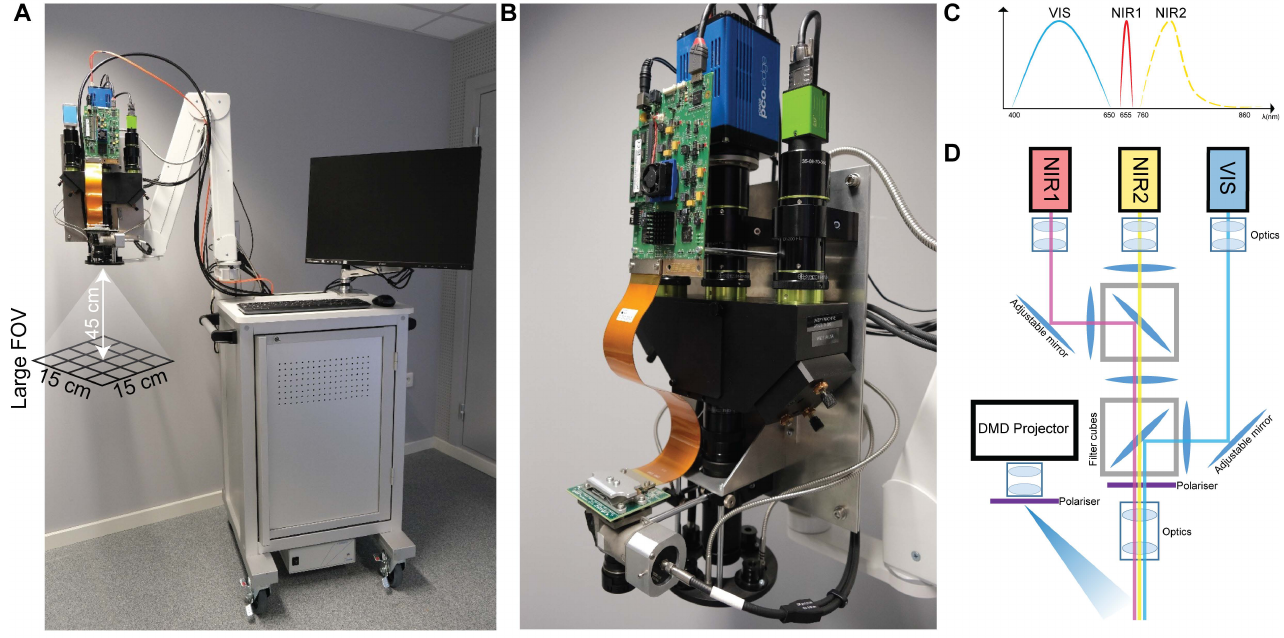
Figure 2. SSOP descriptive figure. ( A ) Preclinical cart for fluorescence, SFDI, and SSOP imaging in the operating room. The imaging head is mounted onto an articulated arm for an easy positioning over the surgical table at the desired working distance. The main body of the cart contains the laser sources, the white light lamp, and the PC workstation. ( B ) Imaging head based on a trident architecture to enclose three separate channels for RGB, NIR1, and NIR2 imaging. A DMD-based projection system is also mounted onto the head for the generation of structured illumination over the FOV. The light source is delivered to the projector via a fiber-based coupling system. An illumination ring is used to homogeneously deliver white light illumination of the surgical field and fluorescence excitation wavelength. ( C ) Schematics of the imaging bands for the trident, namely: the RGB camera (JAI GO-5000C-USB, JAI Ltd., Kanagawa, Japan) covers the VIS bandwidth (400–650 nm); the NIR1 camera (pco.pixelfly USB, Excelitas PCO GmbH, Kelheim, Germany) covers the first near-infrared bandwidth (centered around 665 nm); and the NIR2 camera (pco.edge 5.5, PCO AG, Excelitas PCO GmbH, Kelheim, Germany) covers the second near-infrared bandwidth (700–900 nm). ( D ) Schematics of the optical path in the trident for the co-registration of the three imaging channels, together with the configuration of the DMD-based projector. A pair of filtering cubes are used to isolate the NIR1 and NIR2 channels, and a set of mirrors are used to align the FOV of the three